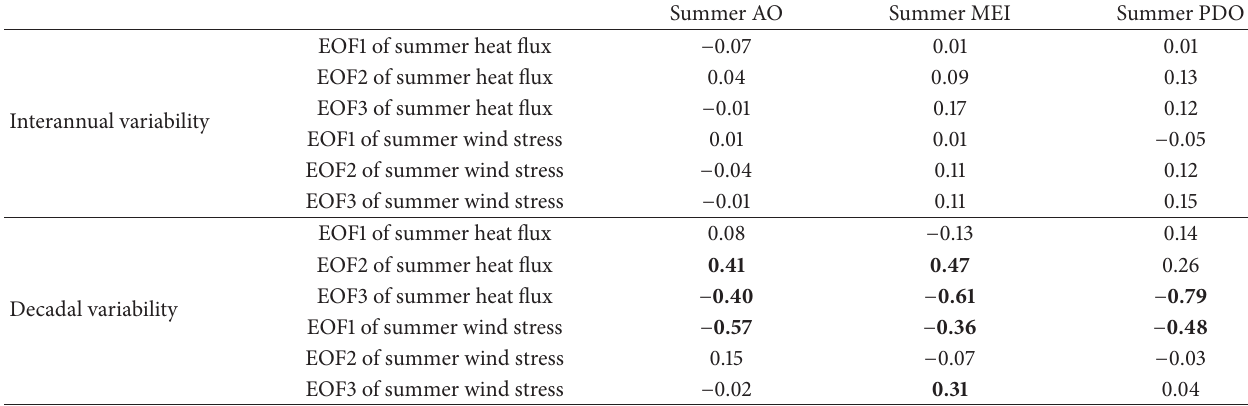
Figure 10: Decadal time series of (a) winter AO, MEI, PDO, EOF1, EOF2, and EOF3 of winter heat flux; (b) summer AO, MEI, PDO, EOF1, EOF2, and EOF3 of heat flux; (c) winter AO, MEI, PDO, and EOF1, EOF2, and EOF3 of winter wind stress; (d) summer AO, MEI, PDO, and EOF1, and EOF2 and EOF3 of summer wind stress. EOF1, EOF2, and EOF3 of heat flux and wind stress are standardized. Table5:CorrelationcoefficientsbetweenEOF1,EOF2,andEOF3ofsummerheatflux,windstress,andwinterAO,ENSO,andPDO,including the interannual and decadal components. Bold texts indicate that the correlations are statistically significant at the 95% confidence